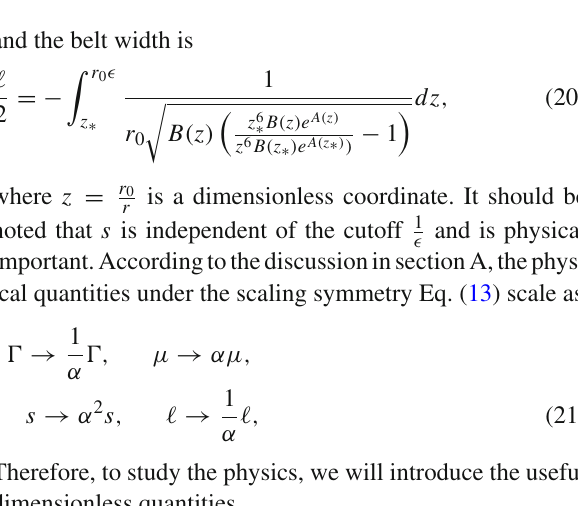
0.8 (green) respectively. The right-hand figure is the case of | b | = 0 . 4 with various width (cid:2) . The three curves in the figure from button to top correspond to increasing (cid:2) , i.e., (cid:2)(cid:8) − 1 = 0 . 165 (green), 0.181 (red) and ∞ (blue)